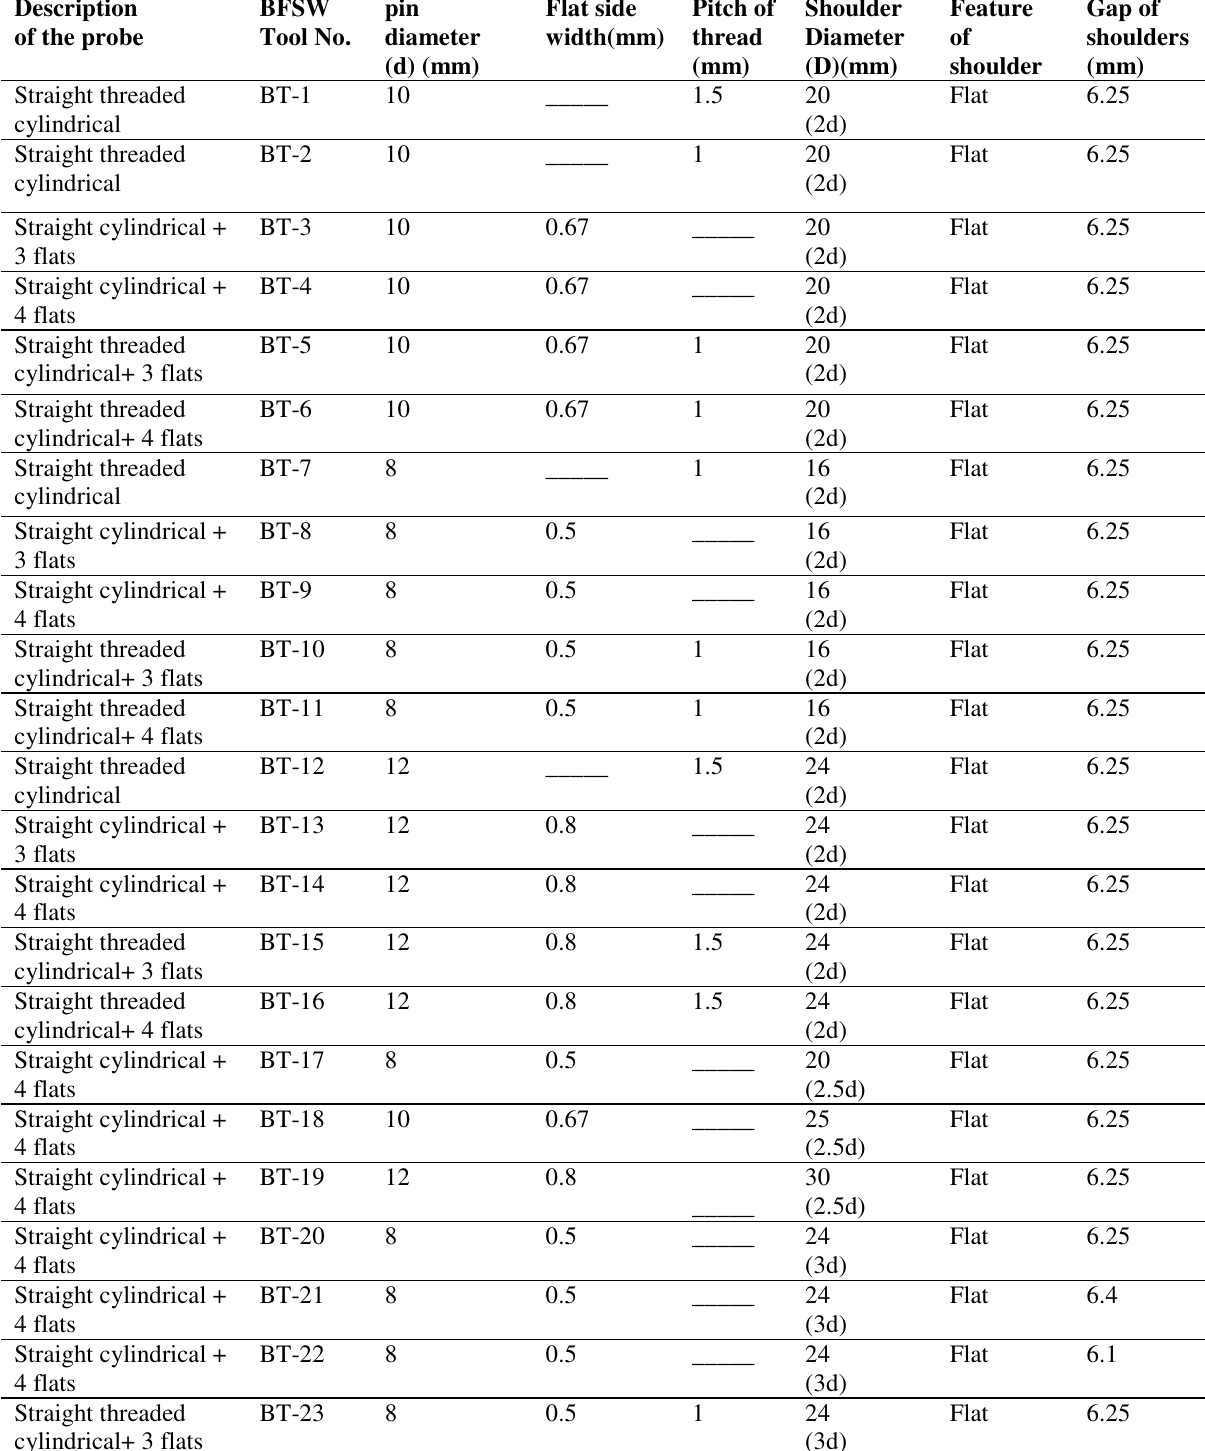
BFSW tools (dimensions and